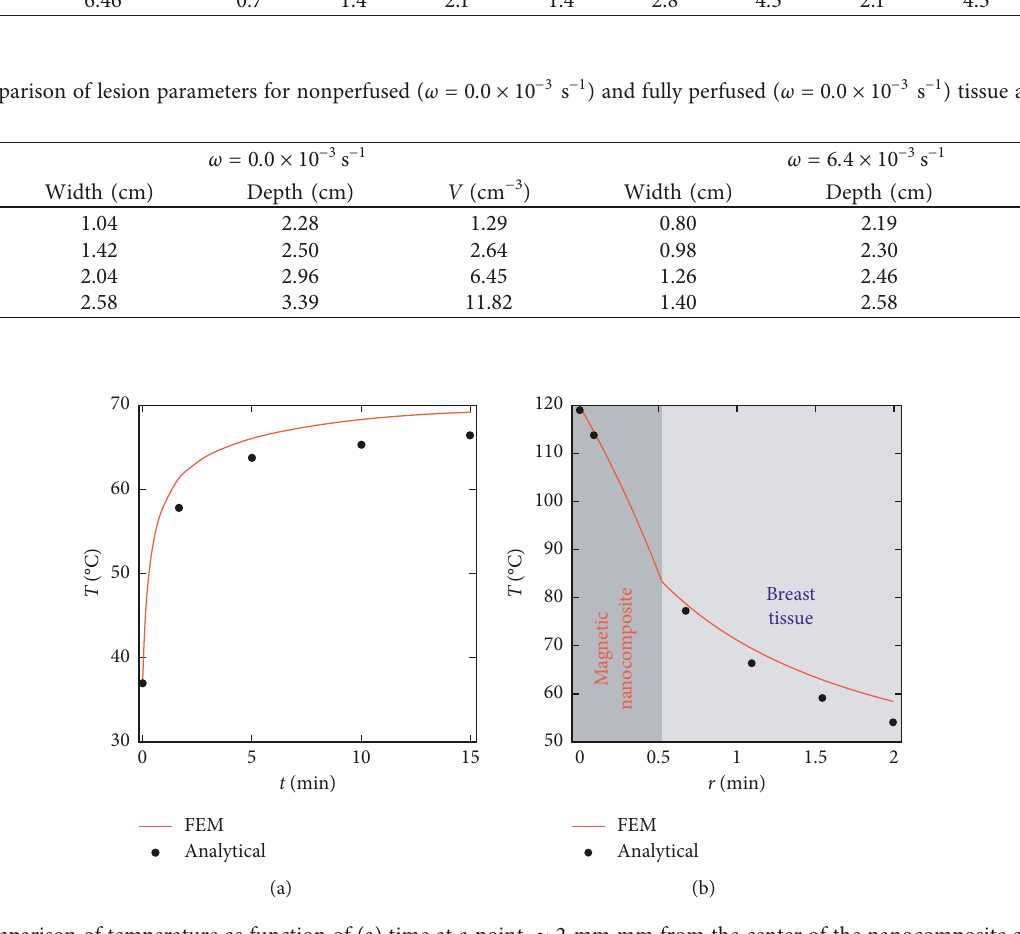
2 mm mm from the center of the nanocomposite and (b) the ≈